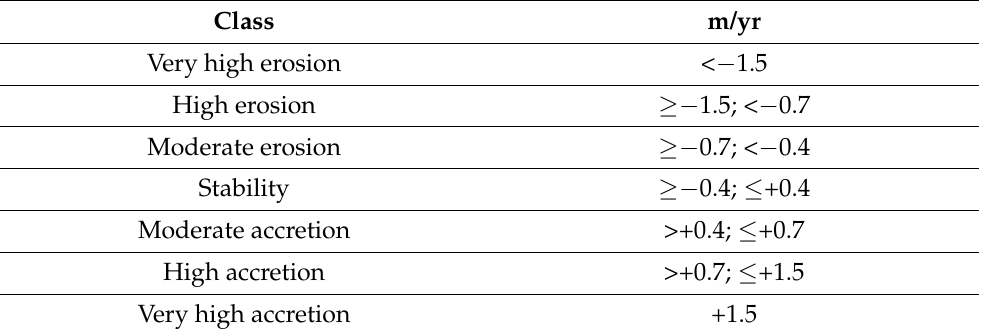
Table 1. Beach evolution classes defined for the present work following the methodology proposed by Molina et al.